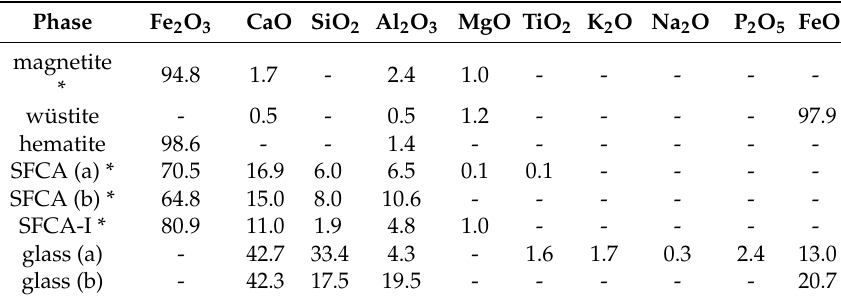
Figure 10. Micrographs of the SM-A sinter microstructure: ( a ) calcium ferrites assemblage (SEM) and ( b ) magnetite-gehlenite (reflected light). F: SFCA, F-I: SFCA-I, G: glass, GE: gehlenite M: magnetite, P: pore. Table 7. Average chemical composition of the secondary phases in SM-A sinter, wt %.